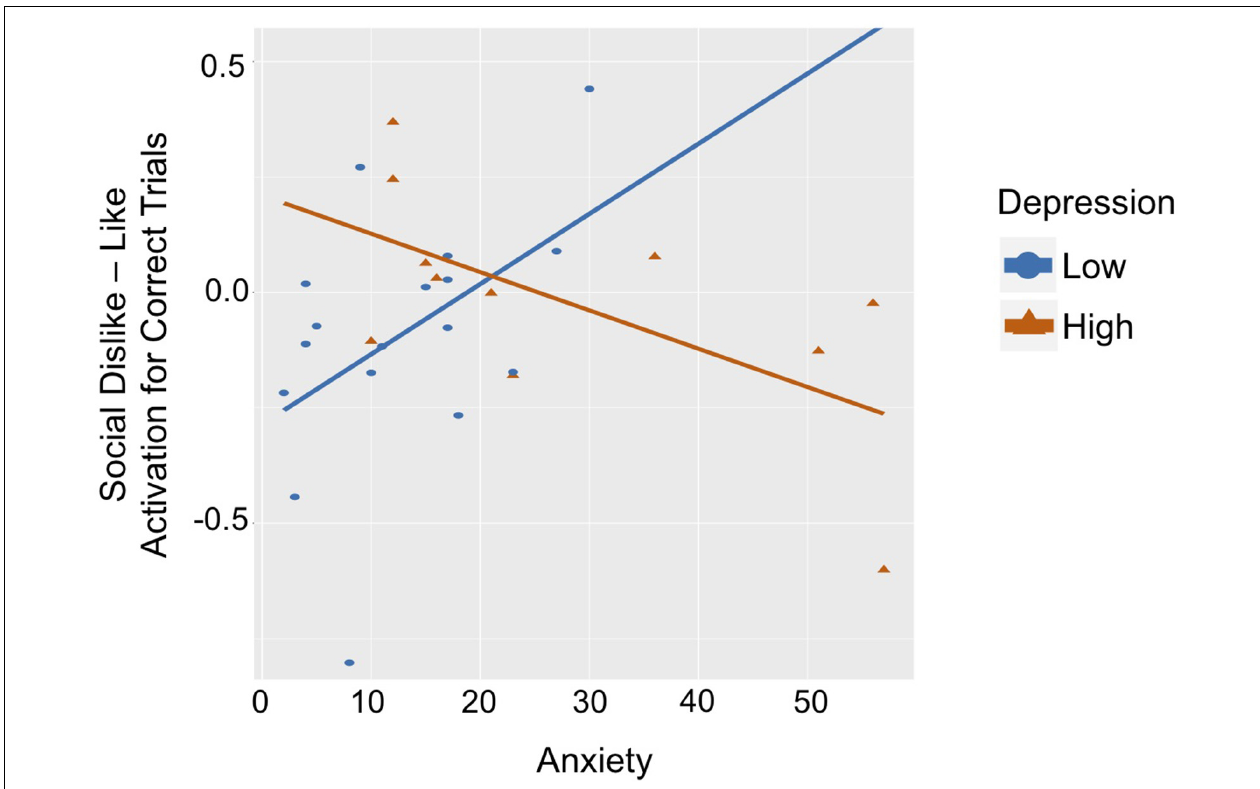
FIGURE 4 | Graph of correlation between ventral striatum response to Social Dislike–Like Correct Outcome Trials and anxiety for the low-depression group (blue line) and high-depression group (red